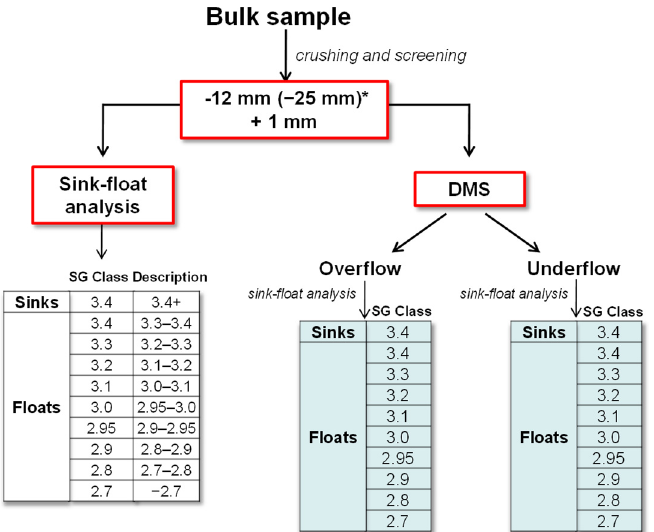
Figure 1. Schematic showing the tests performed on samples split from the bulk sample collected. Samples on which the mineralogical analysis was undertaken are shaded. * A crush top size of 12 mm was used for ore A, and 25 mm for ore B.